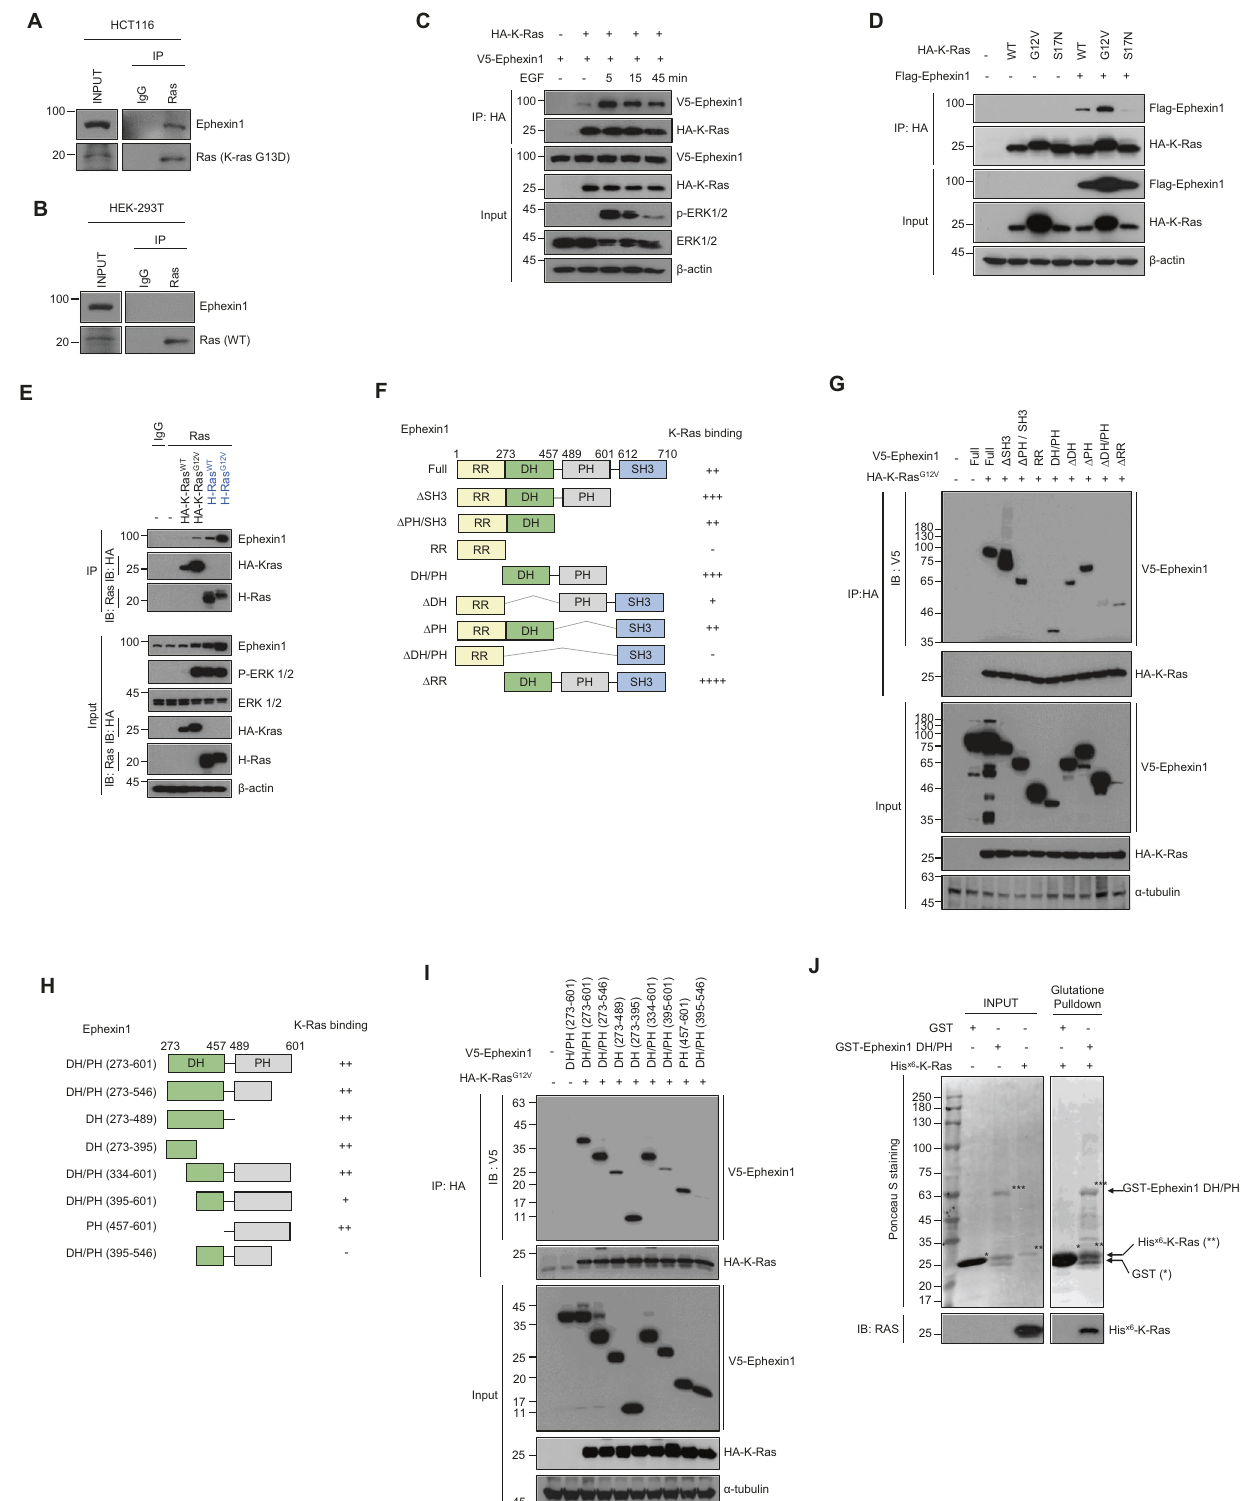
HEK293T cells were harvested and resuspended in PBS. Thereafter 2 × 10 6 HCT116 cells, 2 × 10 6 H1299 cells, 2 × 10 6 H460 cells, and 1 × 10 6 HEK293T cells were injected subcutaneously into the left and right fl anks of BALB/c nude mice. The mice were sacri fi ced after 27 – 41 days, and the tumors were excised. Once the tumors became visible, the tumor size was